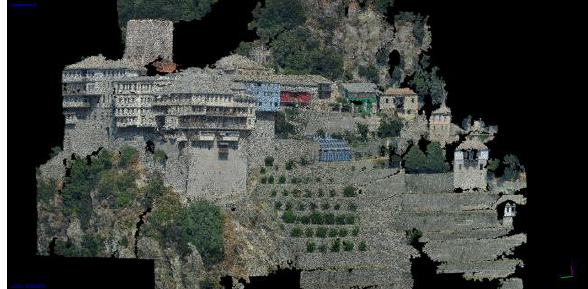
Figure 4 . The Monastery of St. Dionisio. Cloud of points.